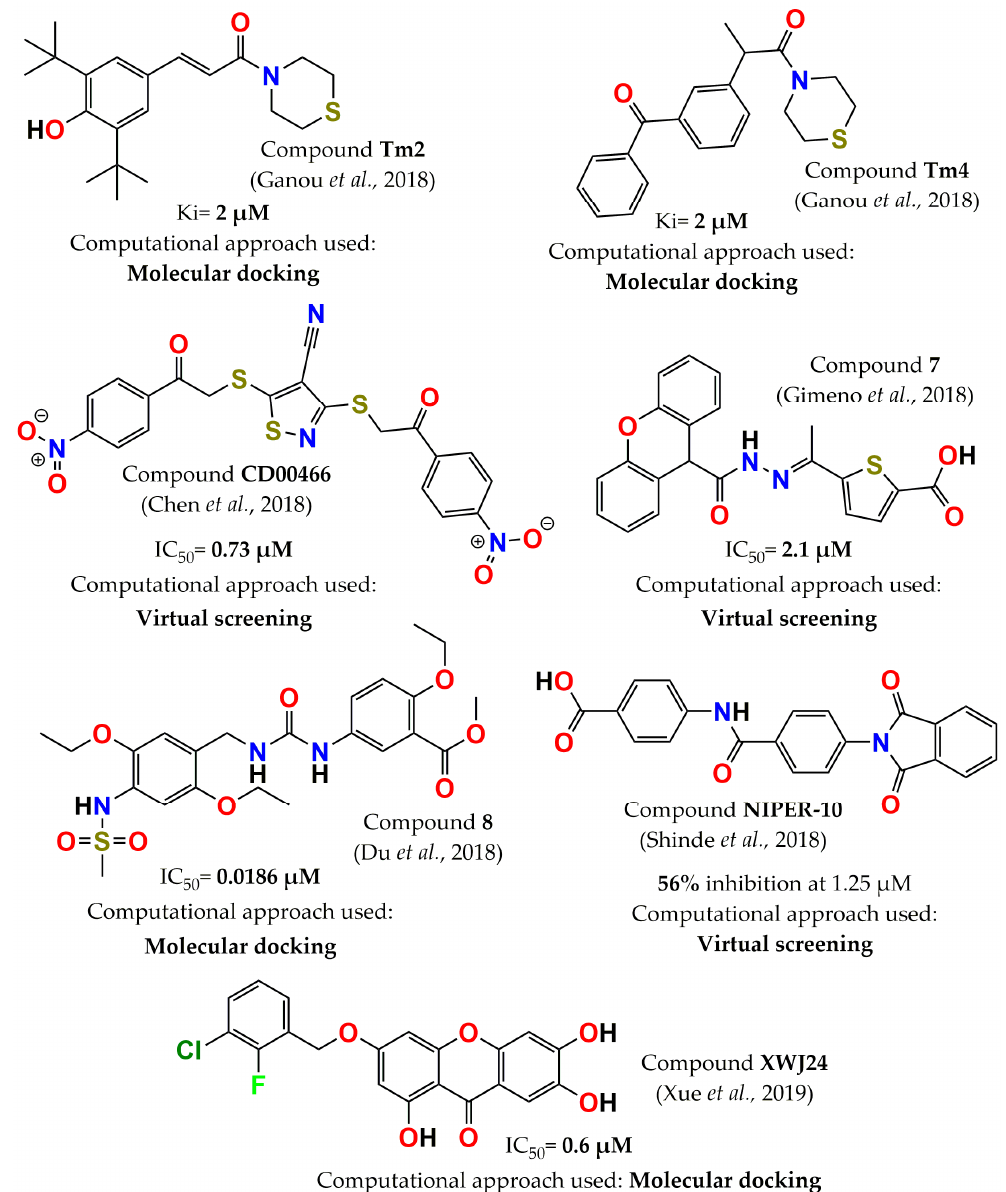
Figure 9. Structure of the most potent PTP1B inhibitors reported between 2018 and 2019 discovered through computational approaches.